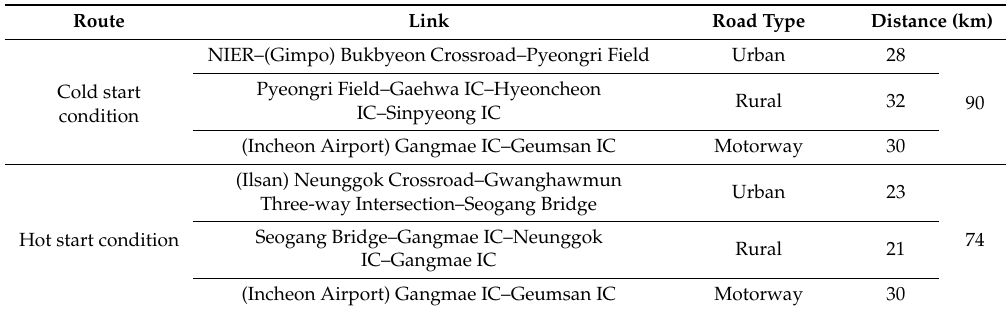
Table 8. Revised road test routes for